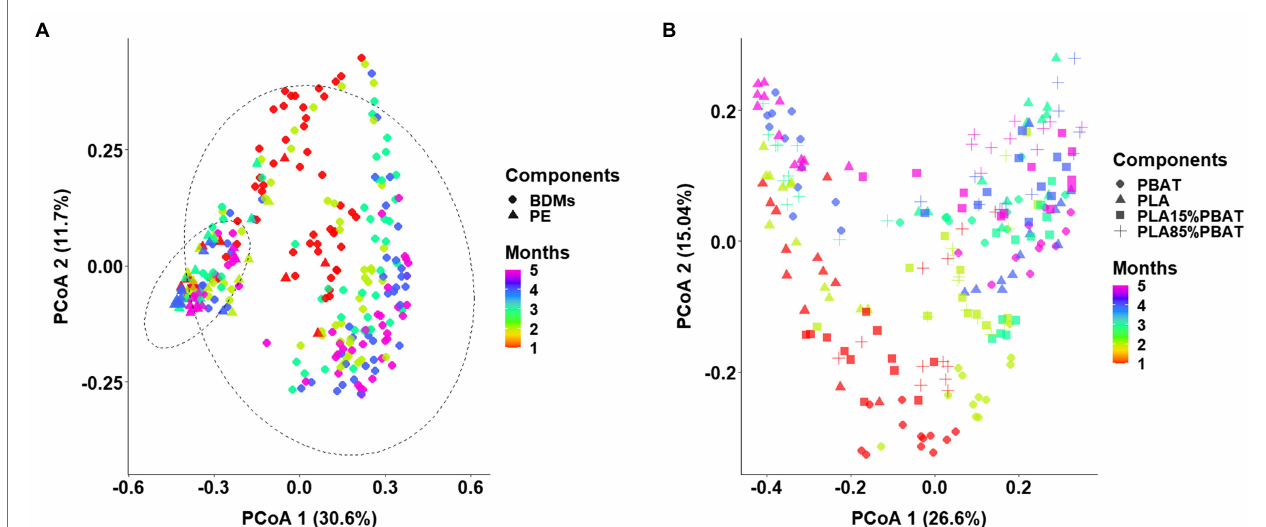
FIGURE 1 | Differences in β -diversity between plastic-associated microbiota under three grouping methods, visualized by principal coordinate analysis (PCoA) based on Bray-Curtis distance. Samples separated into two groups consisting of BDMs (rounded diamonds) and PE (triangles) (A) . After exclusion of PE samples, PCoA analysis shows that the microbiota of four types of BDMs shifted over the 5 months in soil (B) . The five colors represent the 5 months of sampling (A,B)